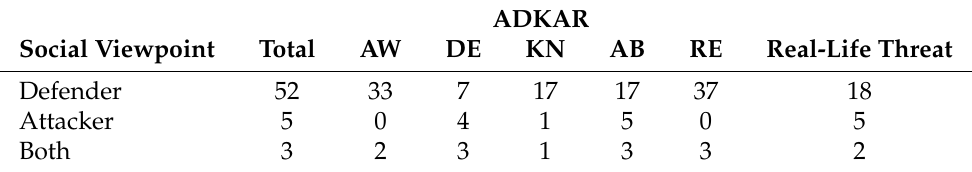
Table 7. The different social viewpoints considered in our inclusions.